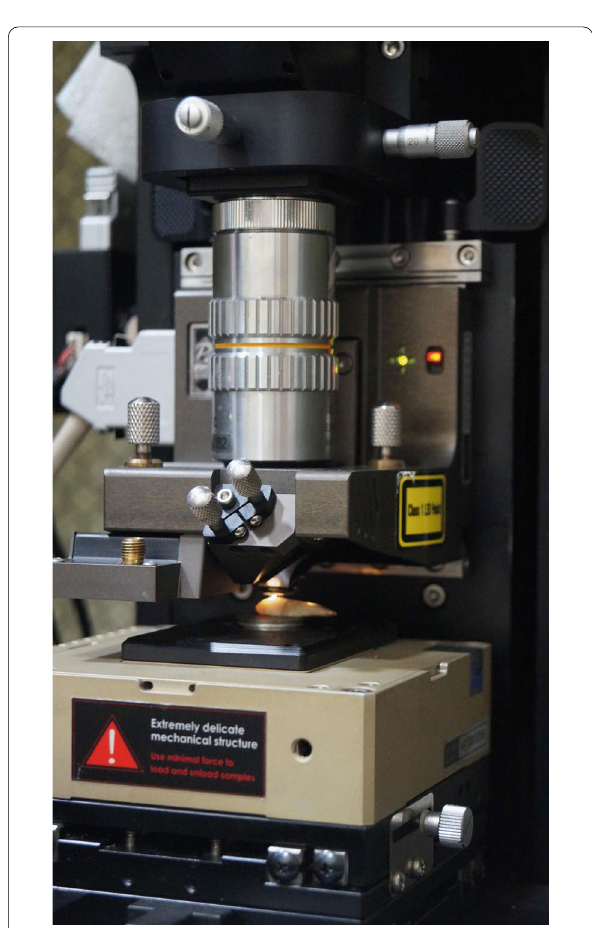
Fig. 3 Prepared sample being subjected to atomic force